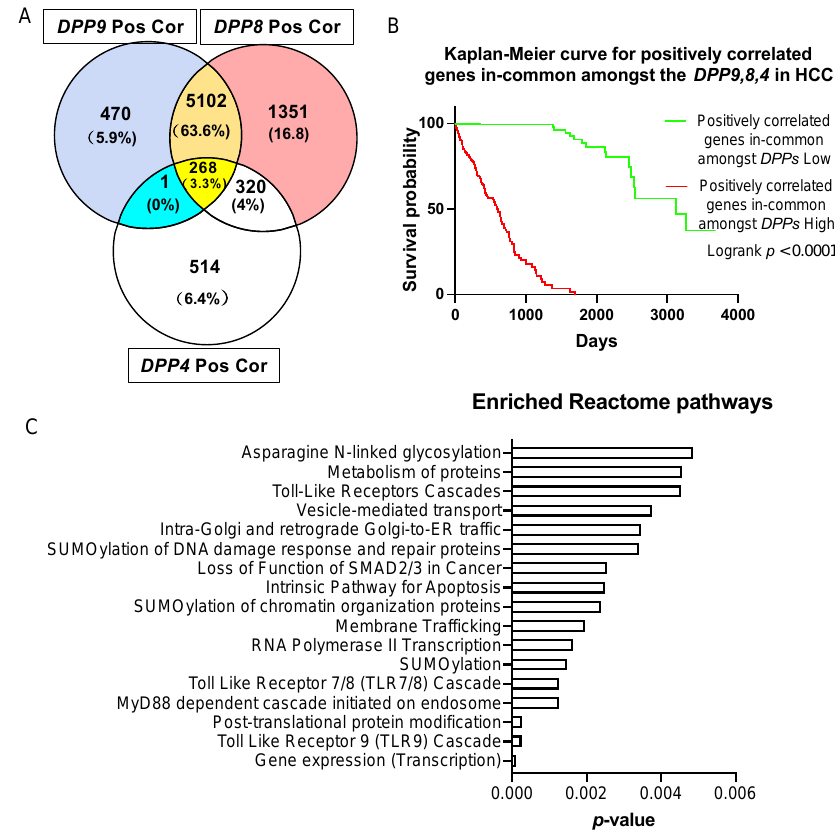
Figure 6. Survival analysis and enriched reactome pathways analysis on genes that were positively correlated with DPP9, DPP8 and DPP4 . ( A ) Venn diagram of the gens that were positively correlated with DPP9, DPP8 and DPP4 . The gene in the blue section is TPRA1 . “Pos Cor” refers to positive correlation. ( B ) Kaplan-Meier curve for the 268 genes that were positively correlated and in-common amongst DPP9, DPP8 and DPP4 in HCC patients ( n = 360). The high (red) and low (green) mRNA expression levels of genes in liver tumors were stratified based on median expression value. p values were calculated by logrank (Mantel-Cox) test. ( C ) Enriched reactome pathways of genes that were positively correlated in-common amongst DPP9, DPP8 and DPP4 .